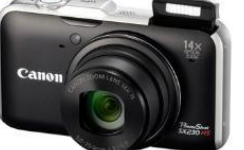
Figure 4. Canon SX230 digital